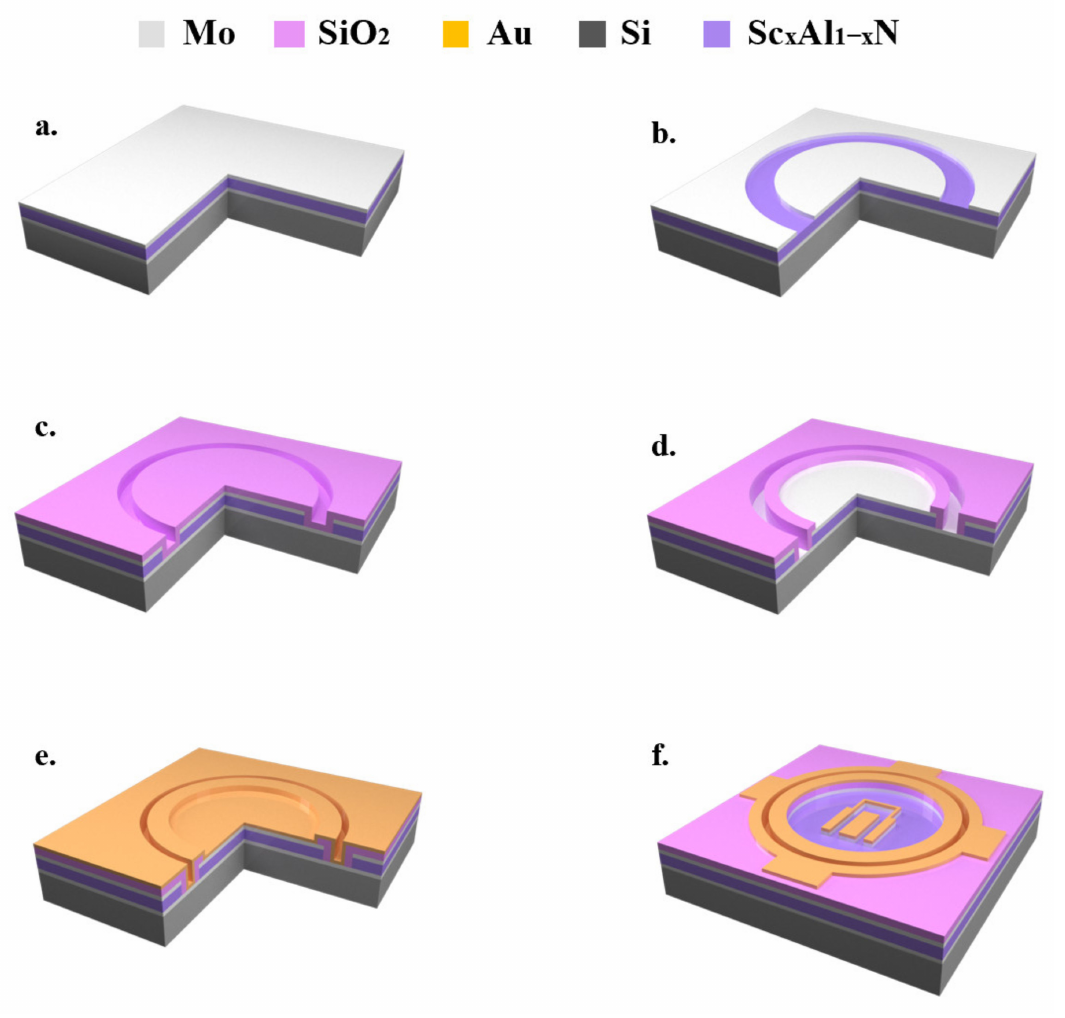
Figure 1. The process flow of the PCM structure. ( a ) a stack of Mo/AlN(AlScN)/Mo is deposited by magnetron sputtering; ( b ) a 0.2 µ m Mo top layer is patterned and etched as a hard mask for the underlying AlN/AlScN layer etching; ( c ) a 1 µ m layer of SiO 2 is deposited by PECVD; ( d ) the top and bottom electrodes are exposed after SiO 2 patterning; ( e ) a 0.5 µ m layer of Ti/Au was deposited; ( f ) the top Au electrode was patterned for electrical